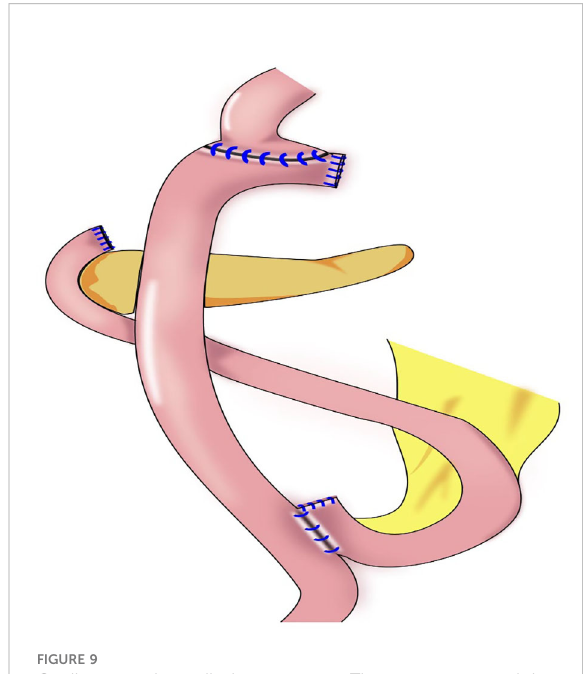
FIGURE 9 Cardia-preserving radical gastrectomy: The remnant stomach is dissociated 2 – 3 cm from the cardia using a linear cutting stapler, Roux-en-Y reconstruction procedure were